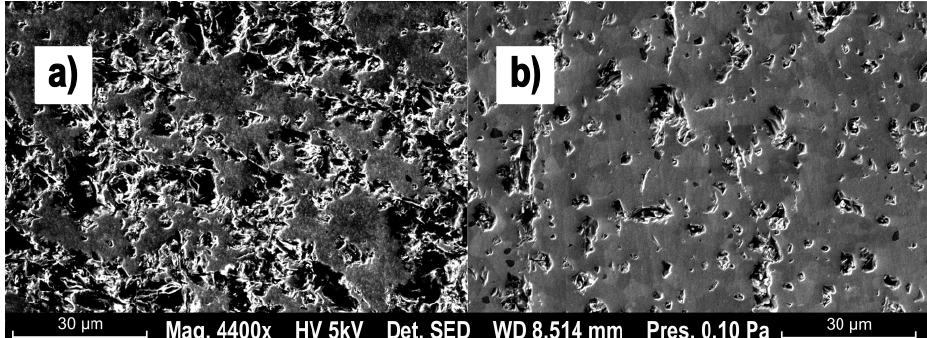
Figure 13. SEM micrographs showing two surfaces: ( a ) brittle material removal; ( b ) ductile material removal.